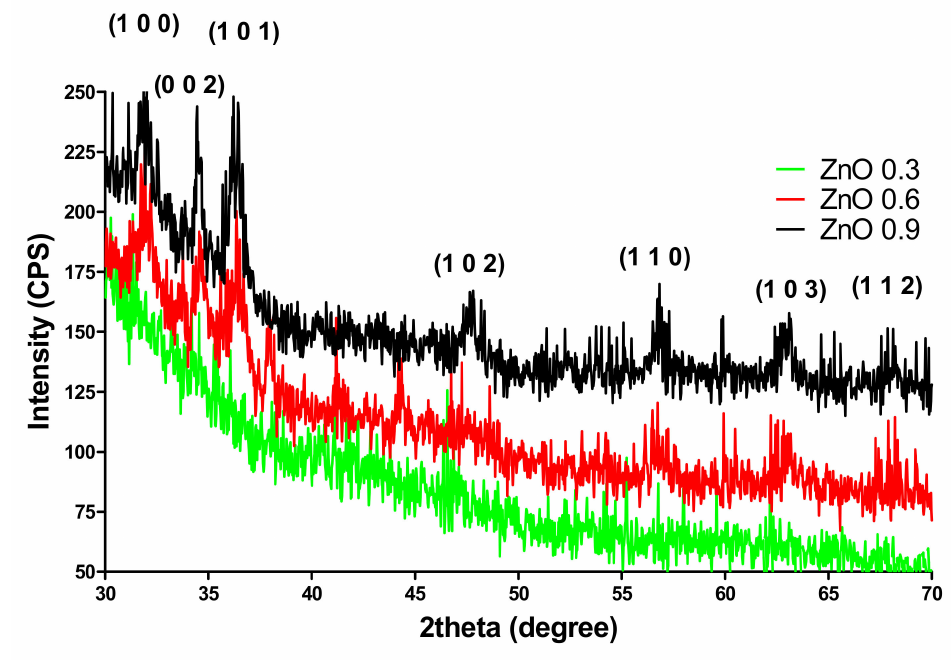
Figure 4. XRD spectra of ZnO NPs-coated dressings (ZnO 0.3; 0.6;